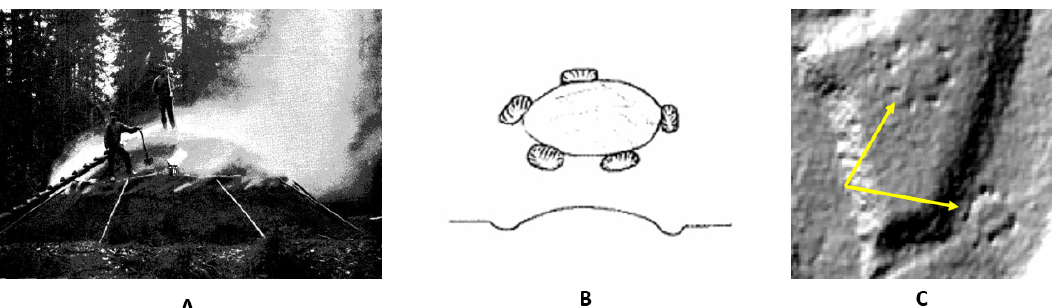
Figure 1. ( A ). Historical image of resmila in use for coal production (credit: ref [19]). ( B ). Schematic drawing of resmila charcoal piles (credit: ref [5]). ( C ). Two examples of resmila in a LiDAR-derived hillshade map (indicated by yellow arrows). These features range in size (10–20 m) in terms of diameter.